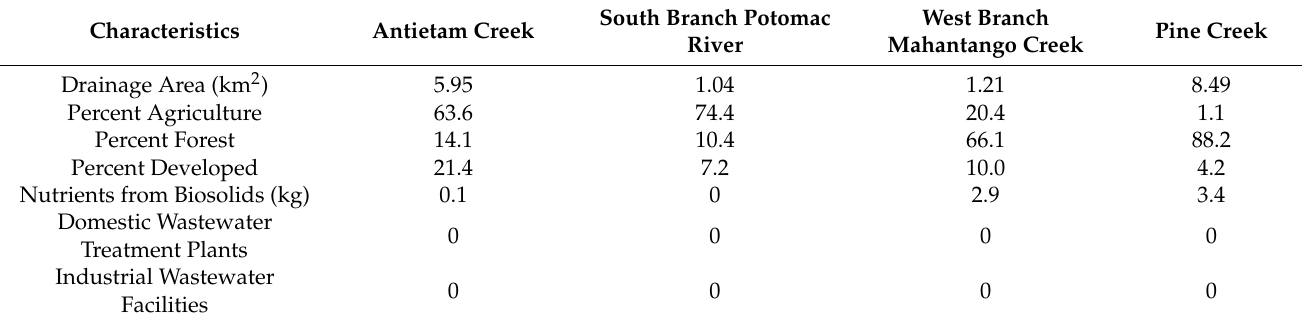
Table 4. Land-use characteristics of the smallmouth bass sampling sites at the immediate catchment scale.